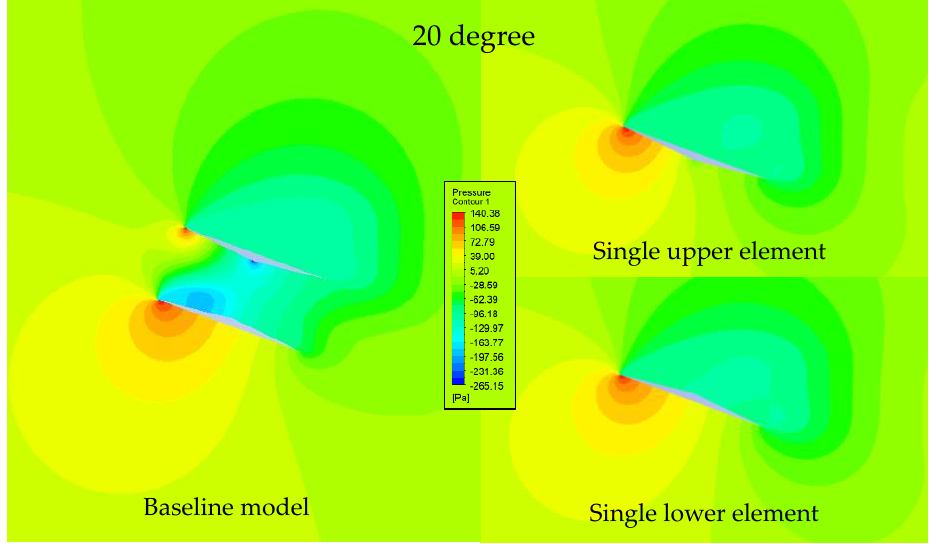
Figure A4. Pressure distributions around the wing elements as single configuration and the baseline configuration (CFD results) at 20 degrees.